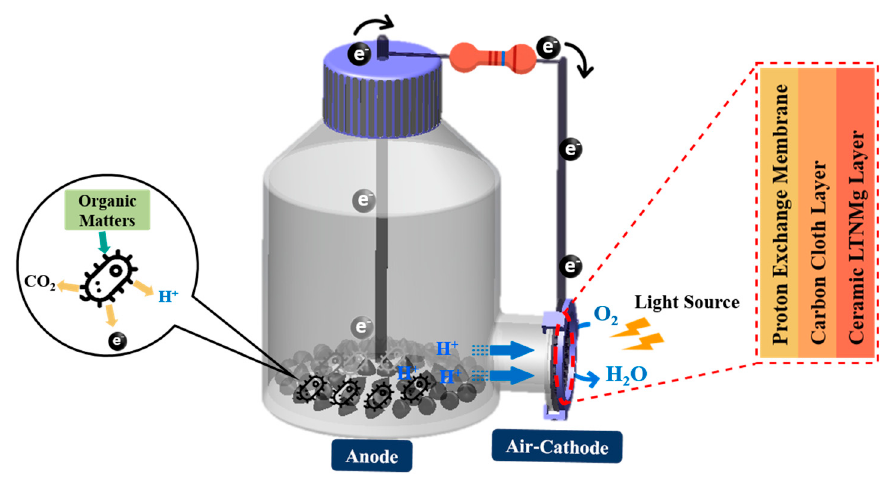
Figure 9. Schematic illustration of the MFC setup.